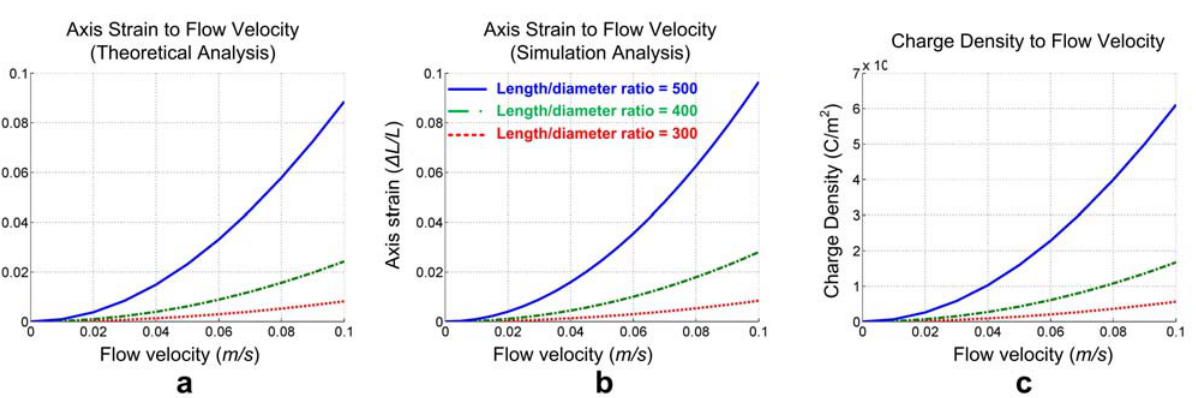
Figure 5. Scaling down analysis; (a) relationship between axial strain and flow velocity with different length/diameter ratio (theoretical analysis), (b) relationship between axial strain and flow velocity with different length/diameter ratio (simulation analysis), (c) relationship between charge density and flow velocity with different length/diameter